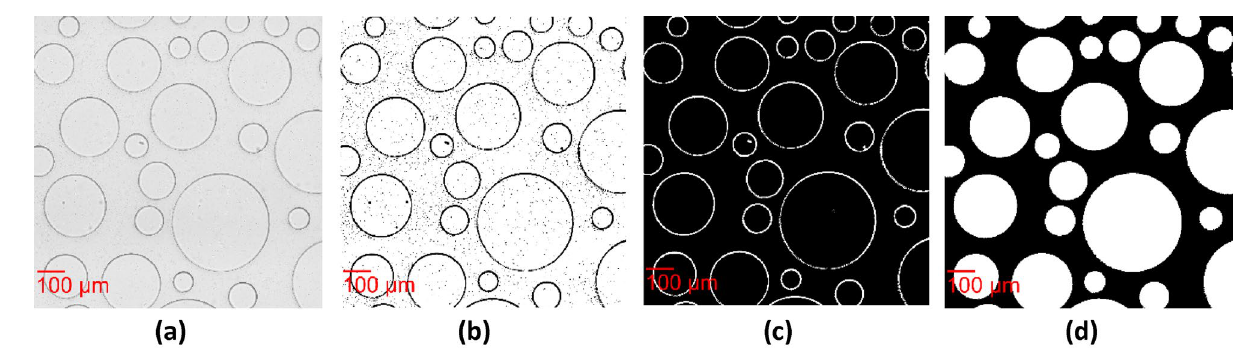
Figure 3. Workflow presenting the extraction of binary images of the pillars from the brightfield images at t = 0 ( a ) Section of dimensions 1.022 mm × 1.022 mm of the raw image of the green channel, ( b ) Image binarization, ( c ) Inversion and filtering of noise and bacteria with “bwpropfilt”, ( d ) Filling the pillars with white with